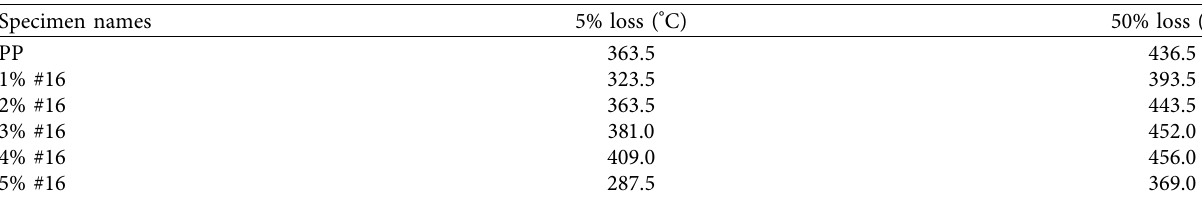
Table 4: Results for TGA